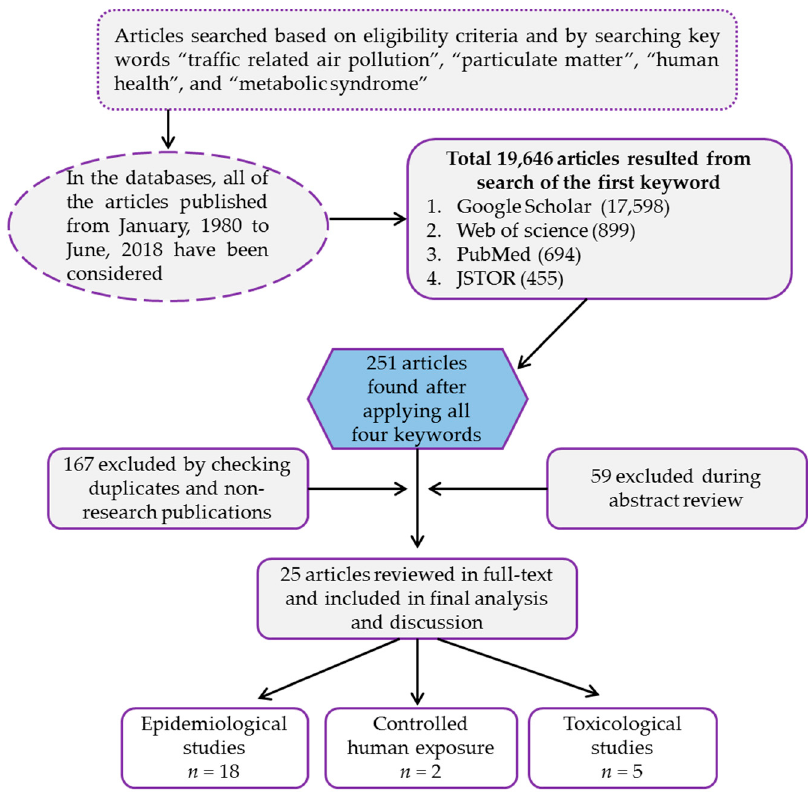
Figure 1. Flow chart of article selection based on the eligibility criteria.